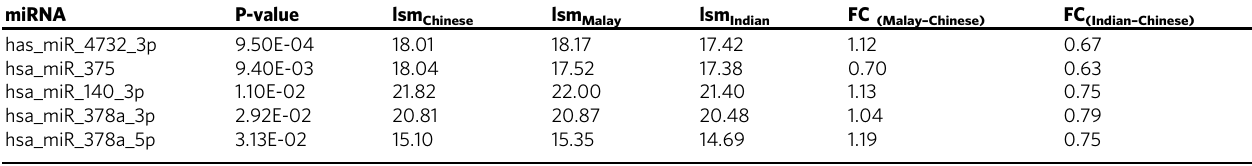
Table 4 Five most differentiated miRNAs between three ethnic groups after adjusted for RT plate effect